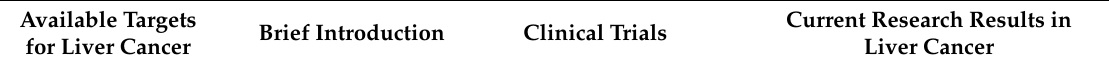
Table 2. Alternative targets and research results for liver